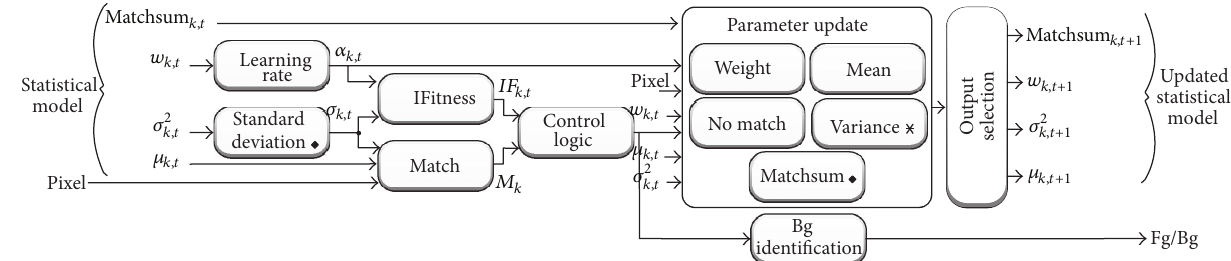
Figure 2: Block diagram of the proposed FPGA implementation. The functionality of the circuit is described in Section 5. The star indicates the circuital block that has been improved by using the truncated binary multipliers. The diamond indicates the circuital blocks that have been improved by using piecewise linear approximation of nonlinear